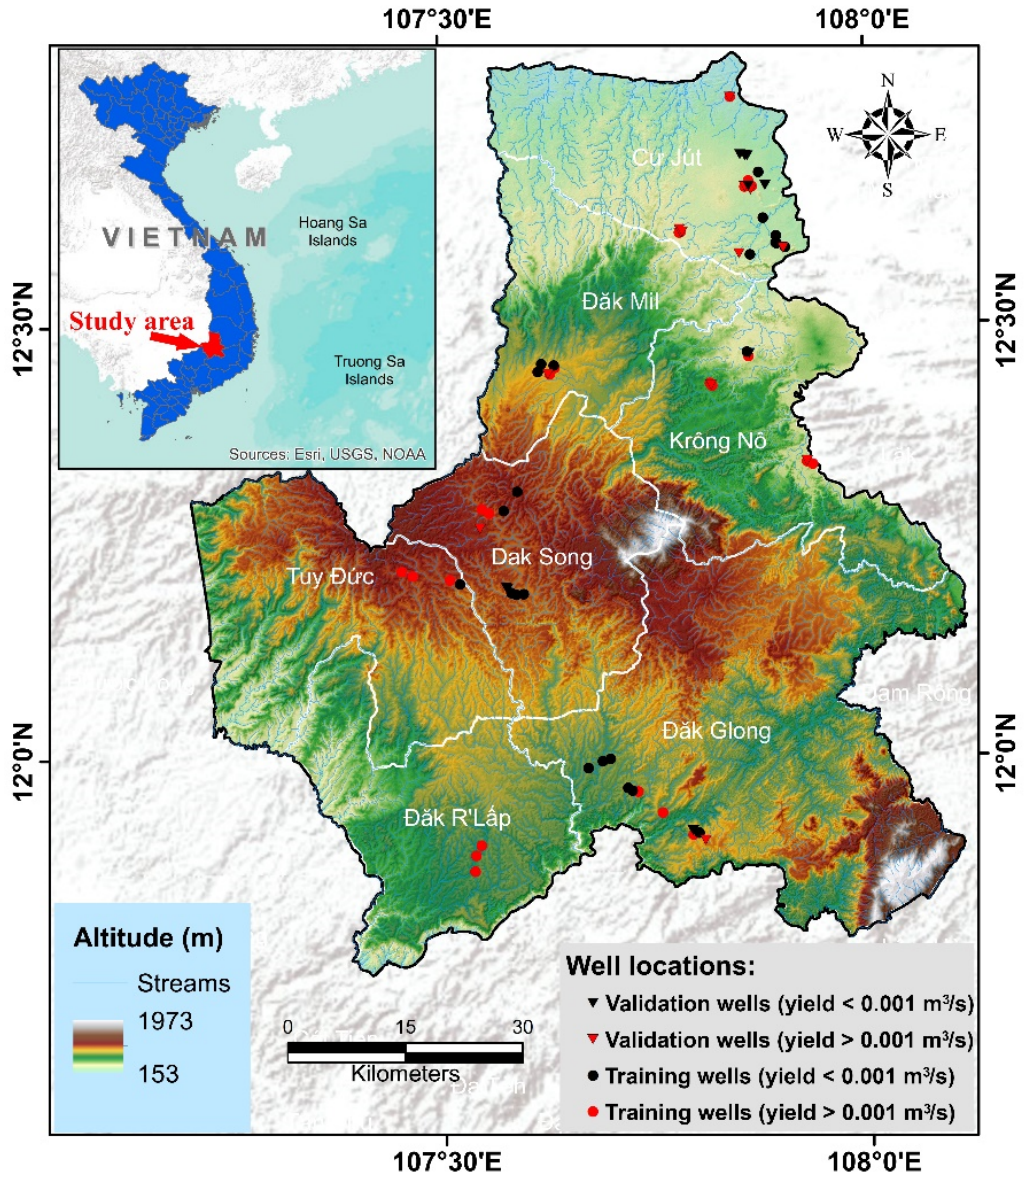
Figure 1. Location map of the study area.